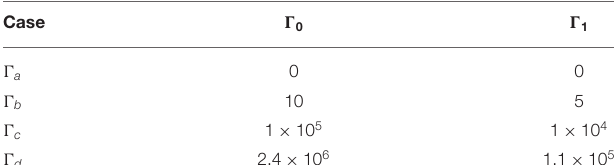
TABLE 1 | Adaptive gains for each case.